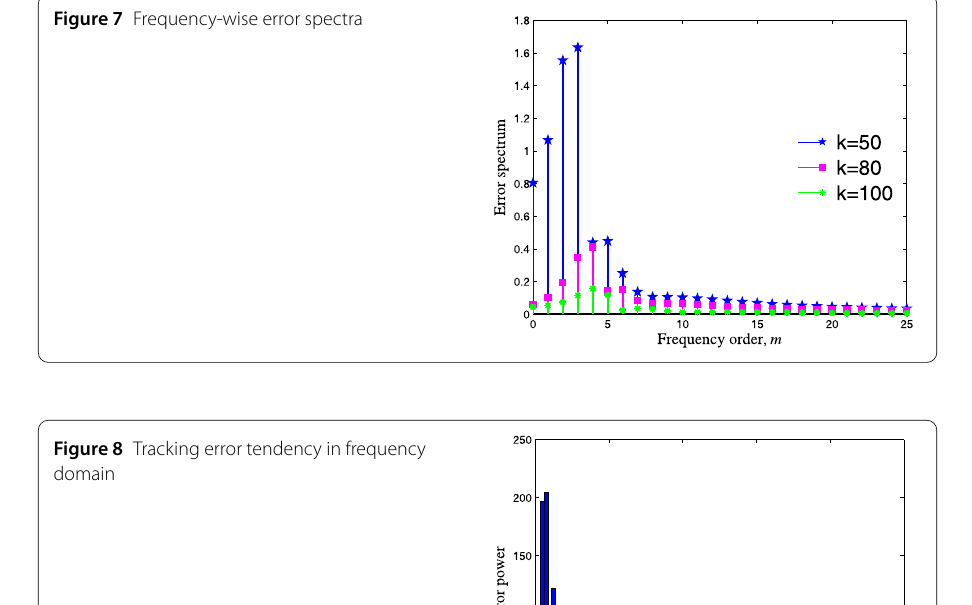
Figure 8 Tracking error tendency in frequency domain